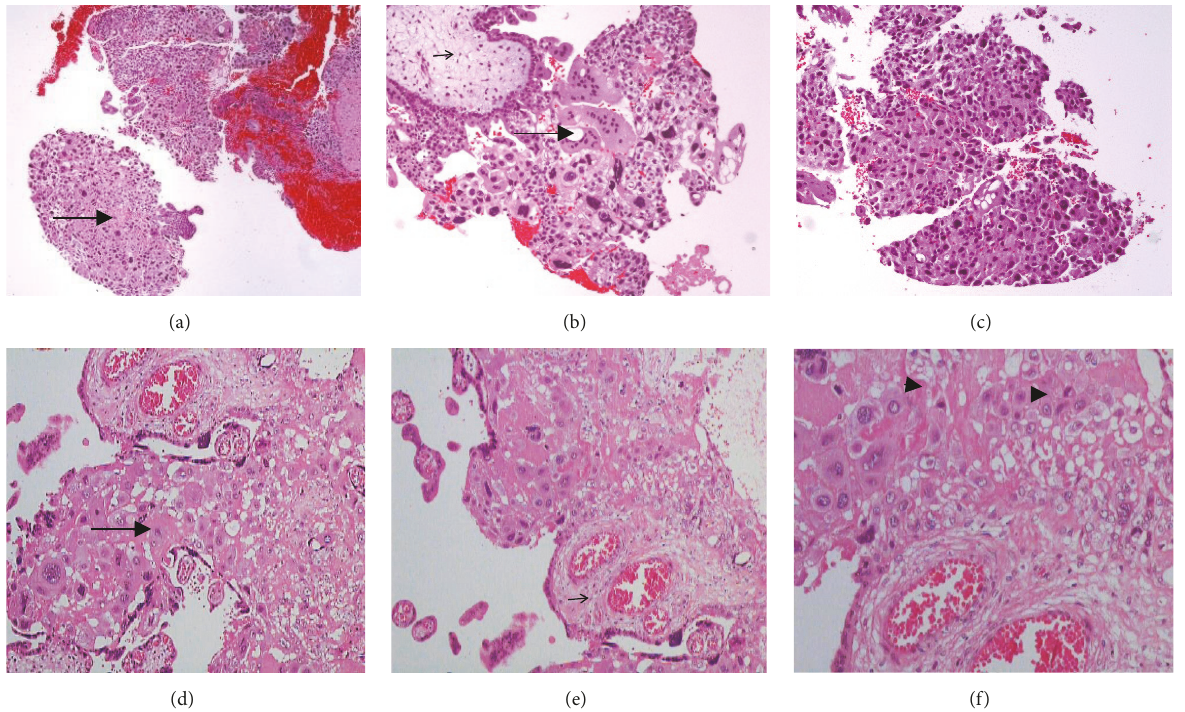
Figure 1: Placental histological features from case 1 at 8 weeks of gestational age [(a), (b), and (c)] and case 2 at 32 weeks of gestational age [(d), (e), and (f)]. Chorionic villi (small arrow) surrounded by tumor trophoblast cells [cytotrophoblast and intermediate trophoblast with patchy small foci of syncytiotrophoblast (arrow)]. Mitotic figures (head